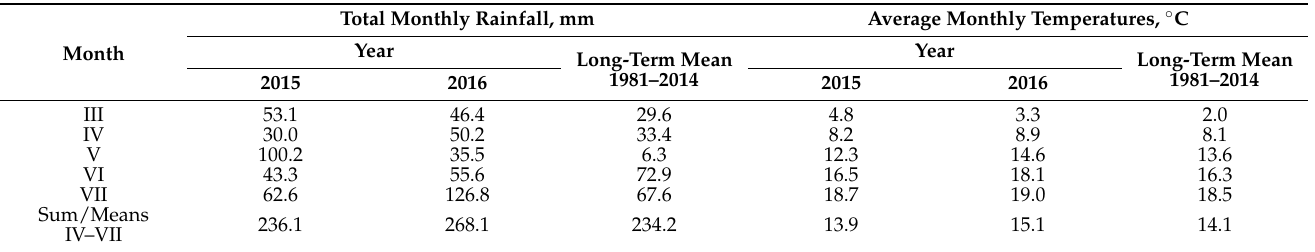
Table 1. Rainfall and air temperatures in 2015–2016, (Institute of Meteorology and Water Management, National Research Institute in Warsaw).